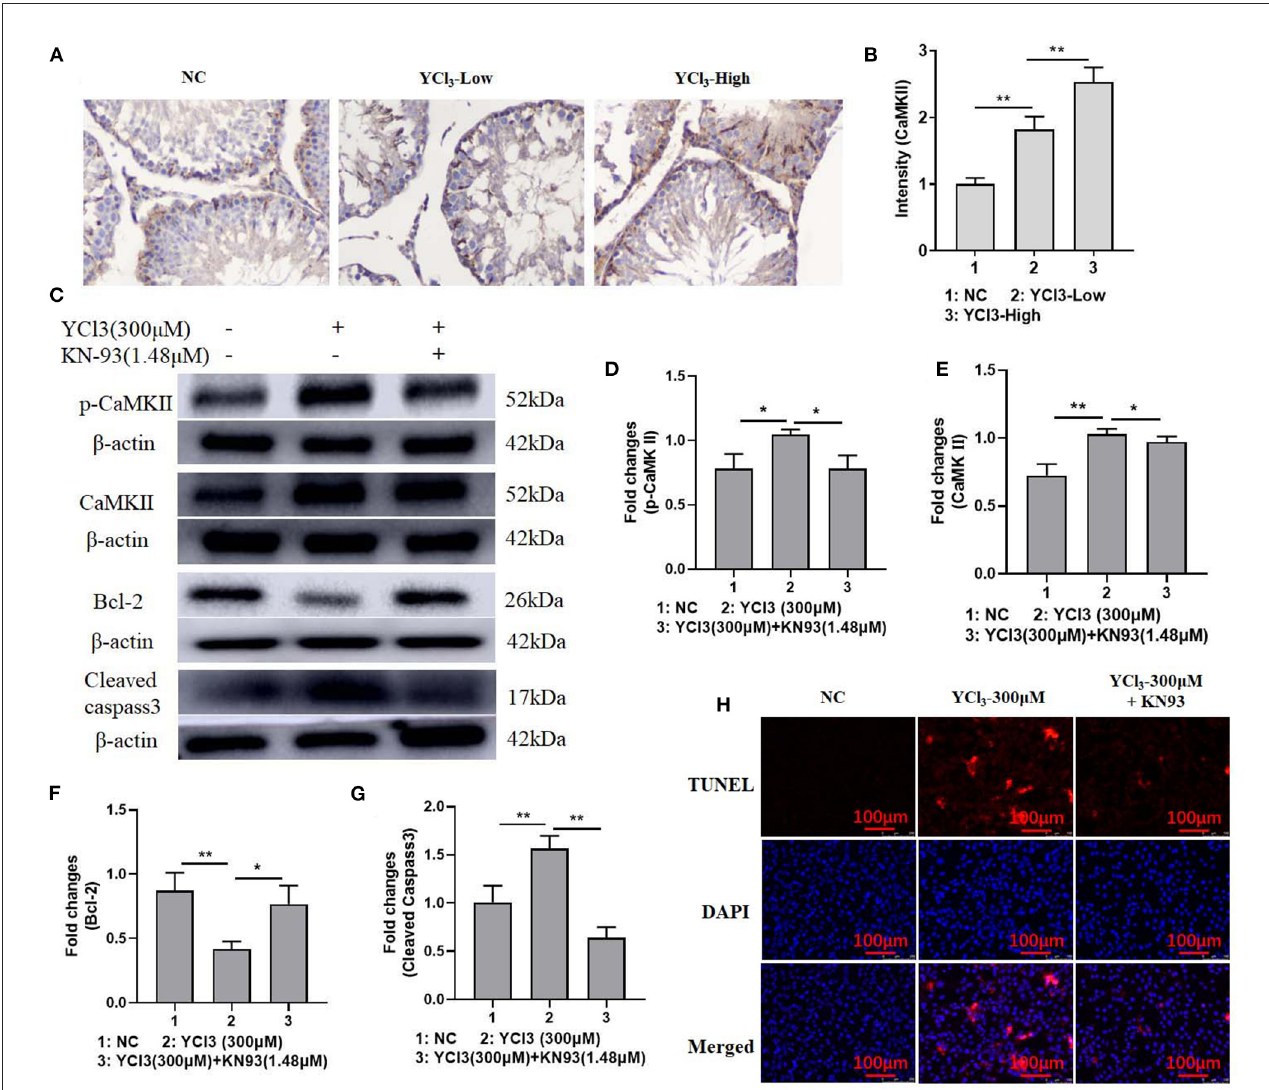
FIGURE4 The effects of YCl 3 on the activity of Ca 2 + /CaMKII axis. (A) The immunohistochemical study (magnification × 200) (A) of CaMKII in YCl 3 -treated rat testicular tissue was tested, and it is quantified by intensity measurement (B) . Western blot assays were conducted for determination of p-CaMKII (C, D) , CaMKII (C, E) , Bcl-2 (C, F) , and cleaved-caspase-3 (C, G) protein expression. TUNEL/DAPI assays were conducted for apoptosis detection (H) . * P < 0.05, ** P < 0.01. NC, negative control; YCl 3 -Low, 12 mmol/L YCl 3 ; YCl 3 -High, 24 mmol/L YCl 3